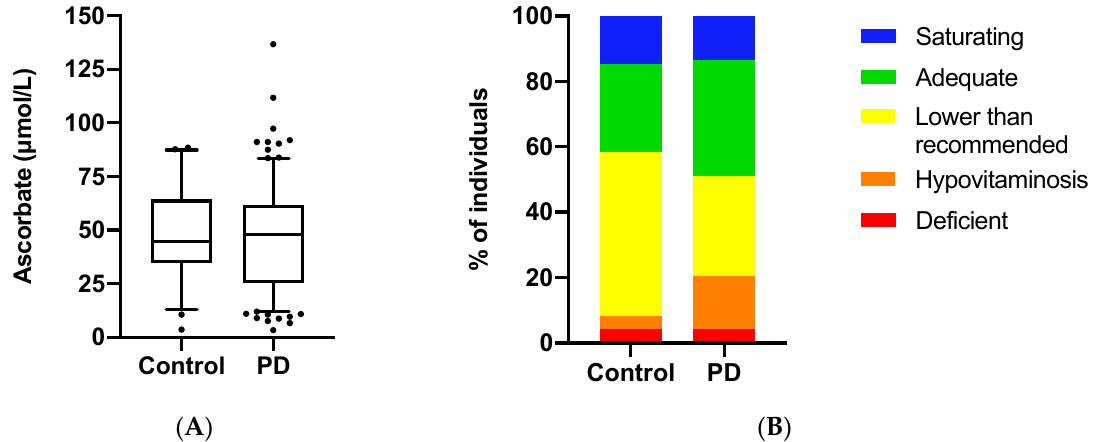
Figure 1. Ascorbate status of the study population. ( A ) Box plots show medians in plasma ascorbate concentrations in the Parkinson’s disease (PD) group ( n = 214) and control group ( n = 48). Boundaries are set at the 25th and 75th percentiles, whiskers at 5th and 95th percentiles, outliers are indicated by symbols. Mean plasma ascorbate concentrations were not significantly di ff erent between the two groups ( p = 0.74). ( B ) Proportion of participants in di ff erent ascorbate categories. Individuals within the Parkinson’s disease (PD) and control groups were classified as having saturating ( > 70 µ mol / L), adequate ( > 50 µ mol / L), lower than recommended ( < 50 µ mol / L), hypovitaminosis C ( < 23 µ mol / L), and deficient ( < 11 µ mol / L) plasma ascorbate concentrations [30]. Categories are shown as percentages. The PD group had a significantly higher proportion of hypovitaminosis C ( p =